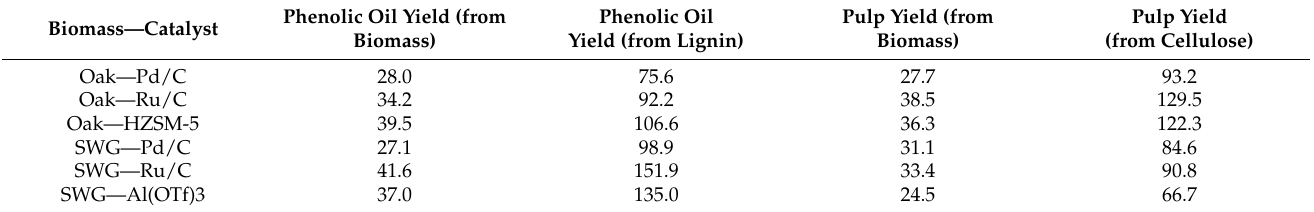
Table 2. Mass balance (wt %) of lignin-first fractionation/depolymerization experiments in ethanol at 210 ◦